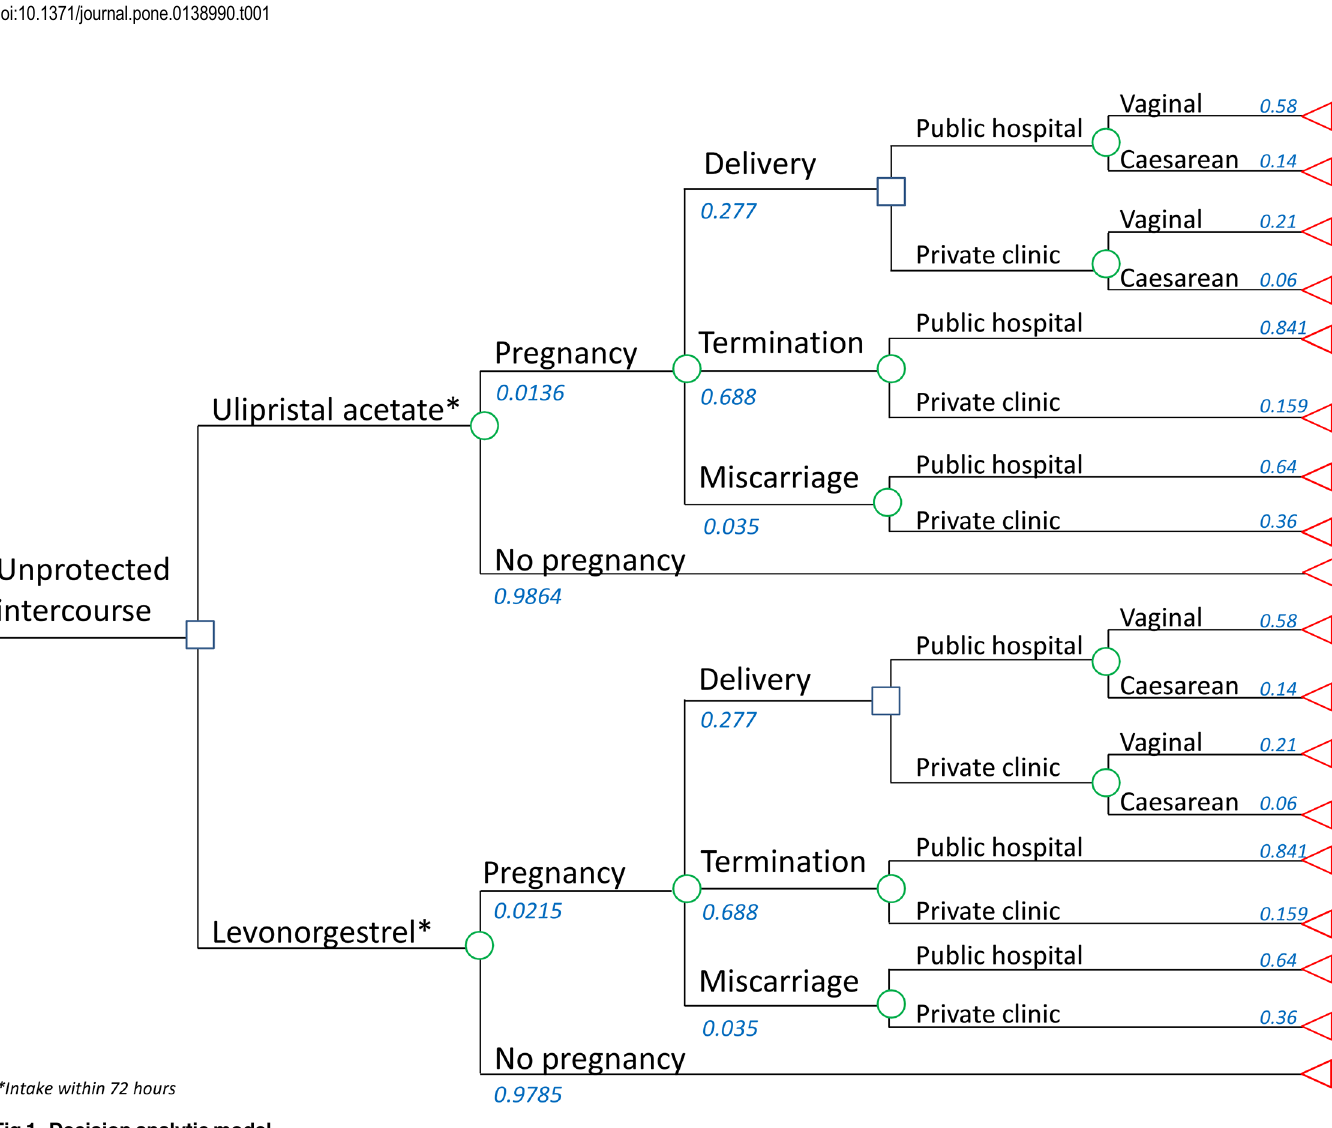
Fig 1. Decision analytic